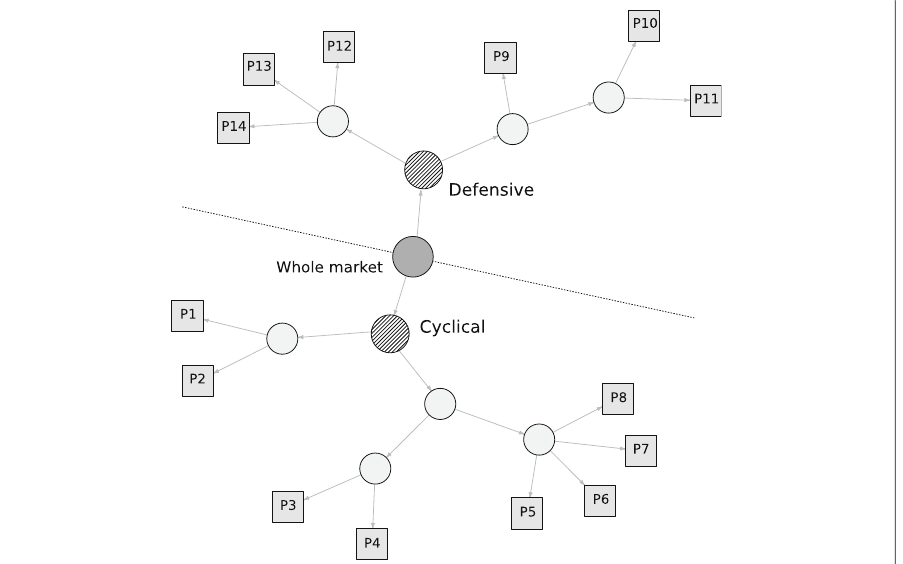
Fig. 1 Network clustering by recursive hierarchical network division. Note: The whole market includes all 1,324 stocks as a single group portfolio. The network is divided into several sub-networks (marked by circles ) so as to maximize the modularity of the network. The two major categories: Cyclical and Defensive groups are created at the first division of the whole market. This modularity based network division is applied to the sub-networks recursively until the final 14 groups (marked by squares ) are created. Further details of the recursive division algorithm is described in Isogai